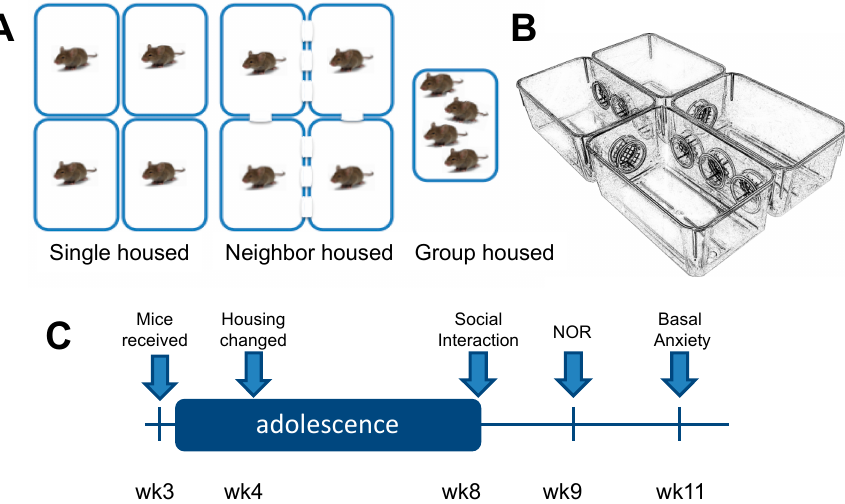
Figure 1. Experimental Design ( A ) Male ( n = 36) and female ( n = 36) C57BL / 6J mice were housed in same-sex groups in one of three conditions from post-natal day 29 (PND 29) until the end of the experiment: Group housed (GH; 4 / cage; n = 12), Neighbor housed (NH; 4 / complex; n = 12) or Single housed (SH; 1 / cage; n = 12). Food and water were available ad libitum. ( B ) The neighbor